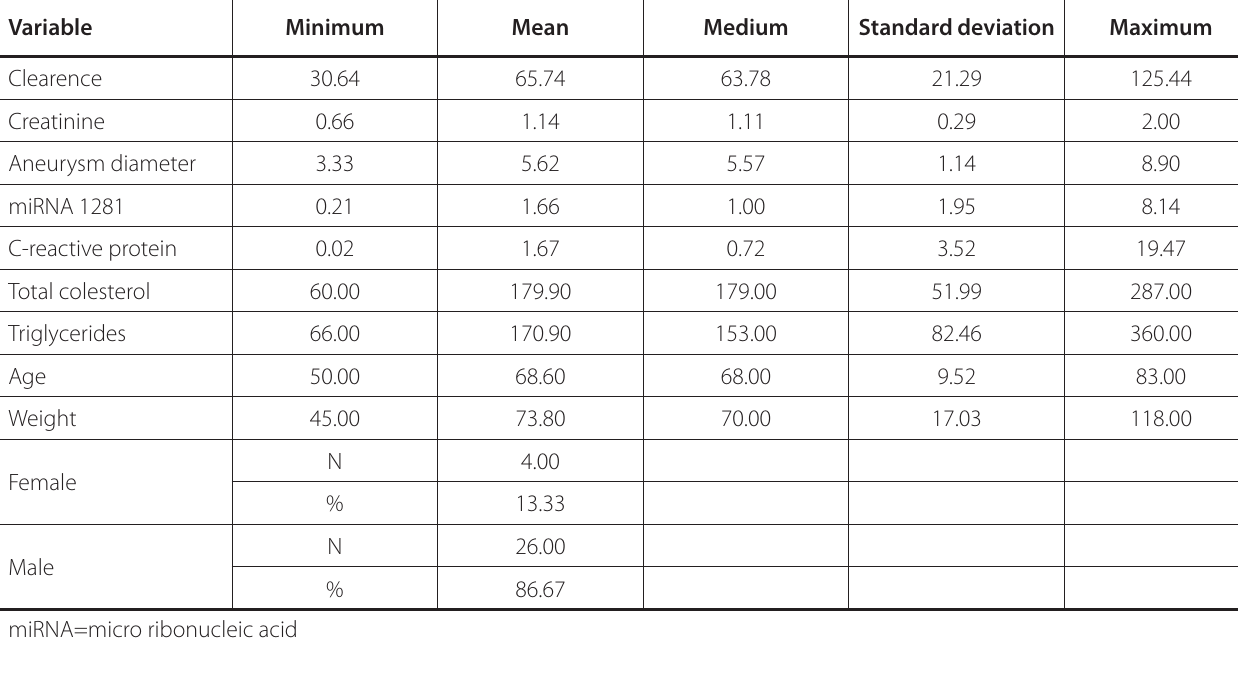
Table 1 . Clinical and demographic data of included patients.